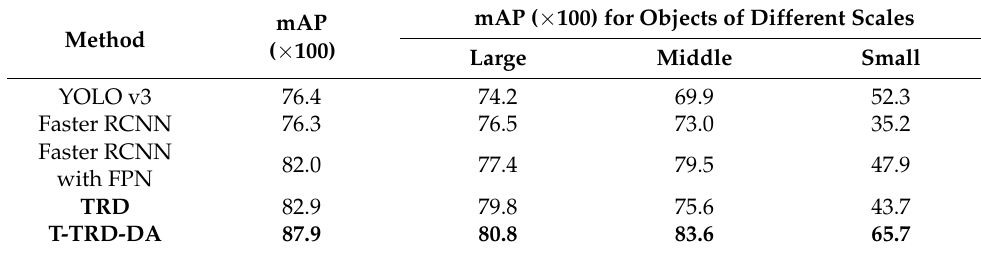
Table 2. Results for objects of specific scale ranges on the NWPU VHR-10 data set.